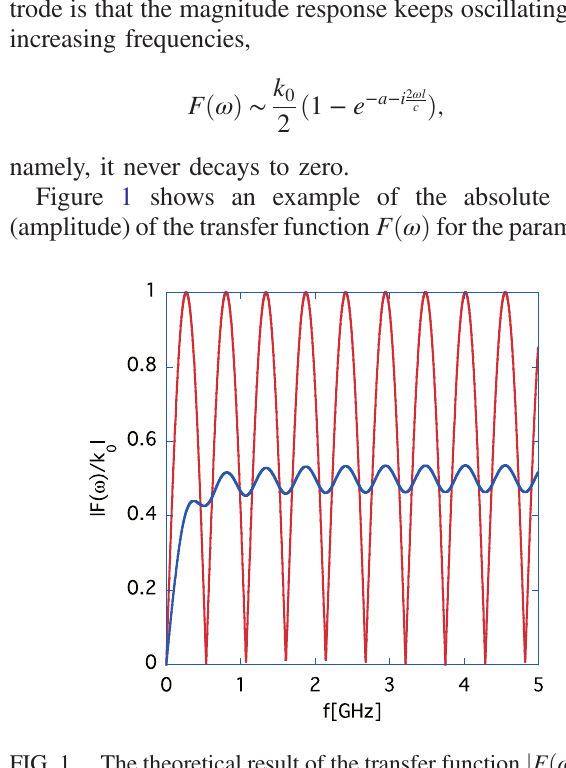
FIG. 1. The theoretical result of the transfer function j F ð ω Þj for Linnecar ’ s exponential electrode for the case of a ¼ 2 . 63 and l ¼ 280 mm (the blue line). The red line shows the amplitude of the transfer function for a rectangular